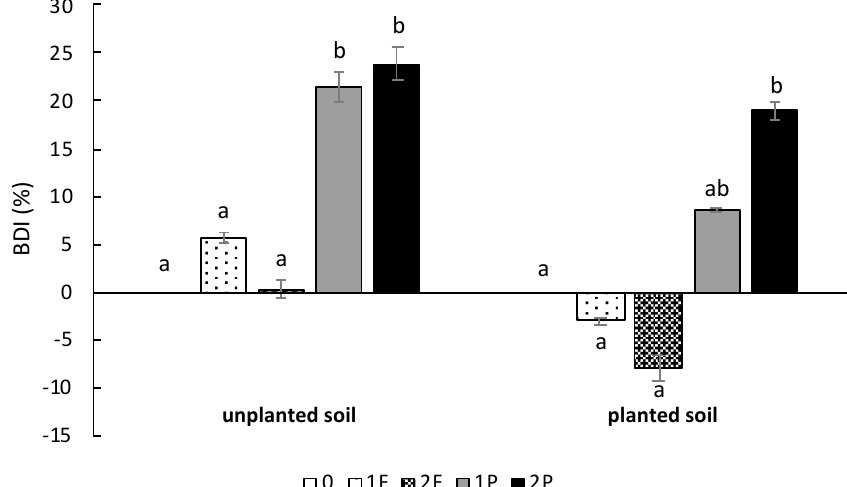
Figure 2. Impact of di ff erent field amendments on the percentage of biological denitrification inhibition (BDI). BDI (%) was calculated in relation to unamended soil for soil treatments and unamended plants for plant treatments. Unamended (0), one fertilizer application (1F), two fertilizer applications (2F), one procyanidin application (1P), and two procyanidin applications (2P). n = 4 for each treatment. Vertical bars indicate standard errors. Di ff erences in letters (a, b and ab) indicate a di ff erence in treatment (Nemenyi’s test; α < 0.05).